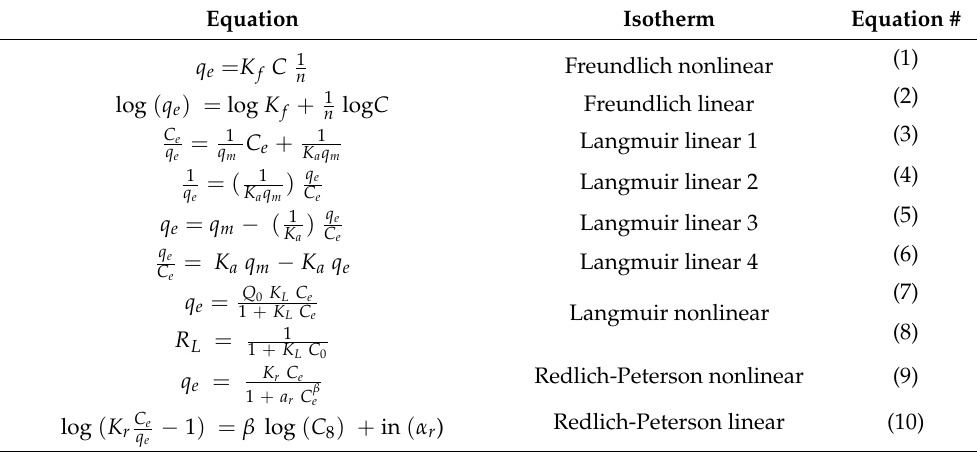
Table 2. Freundlich, Langmuir, and Redlich–Peterson